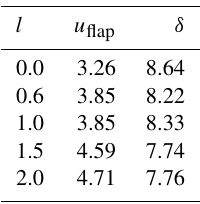
Table 2. Blade deflection and tip-to-tower clearance in meters.